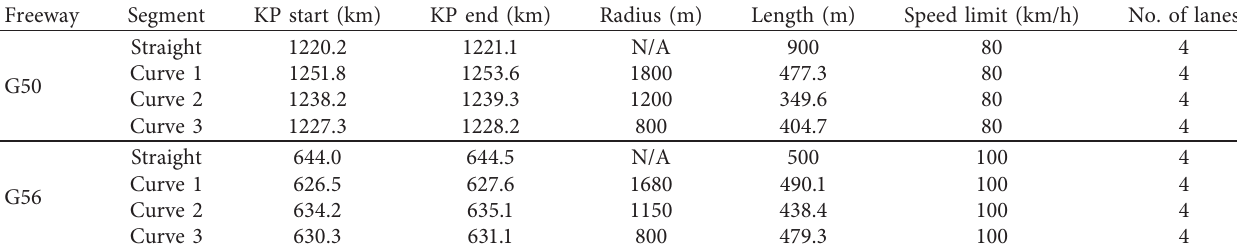
Table 1: Segments